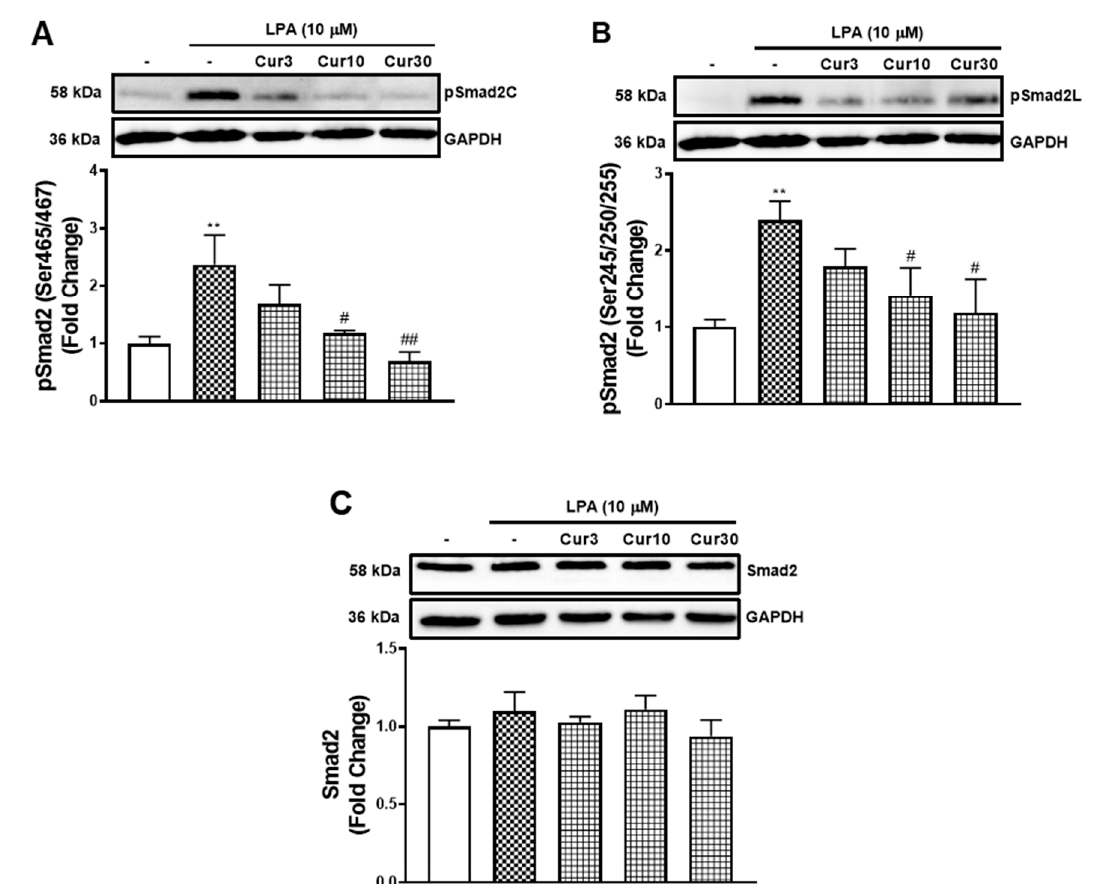
Figure 4. The effect of curcumin on LPA stimulated Smad2 signalling. VSMCs were pre-incubated 3, 10 and 30 µM curcumin for 30 min before treatment of LPA (10 µM) for 30 min. Blots were probed with primary antibodies specific to ( A ) phospho Smad2 (Ser465/467) (1:1000), ( B ) phospho Smad2 (Ser245/250/255) (1:1000), ( C ) Smad2 (1:1000) and secondary HRP conjugated rabbit IgG antibody (1:2000). Blots are representative of three independent experiments. Figure A and B share the same blot of GAPDH. Histogram represents band density expressed as fold per basal (presented as mean ± SEM) after normalised to GAPDH. Statistical significance was determined by one-way ANOVA, followed by least significant difference post-hoc analysis. ** p < 0.01 versus basal; # p < 0.05 and ## p < 0.01 versus LPA only treated